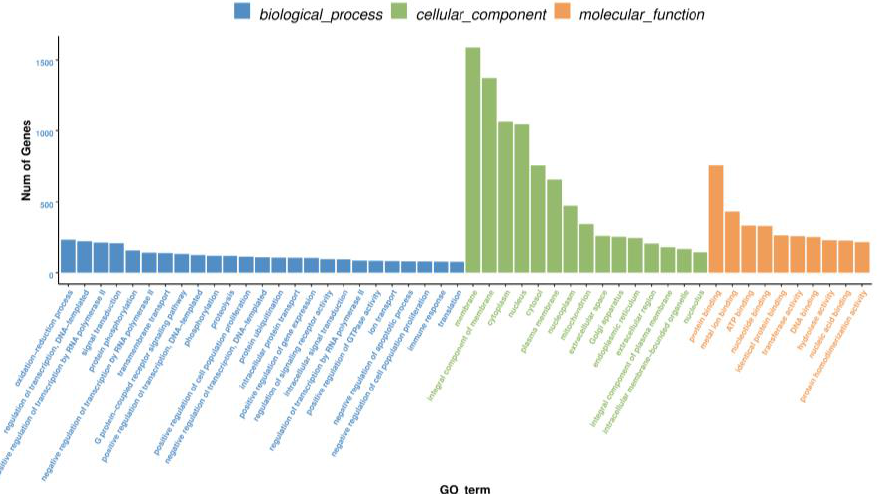
Figure 6. GO functional analysis of the potential targets of the DEmiRNAs.